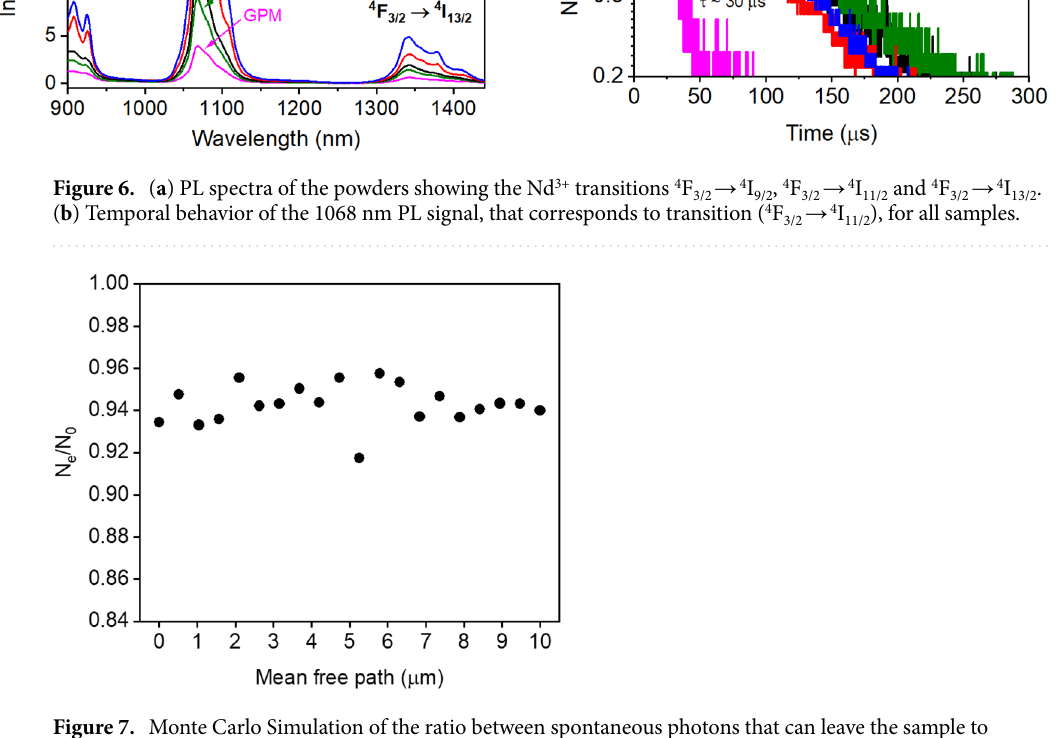
Figure 7. Monte Carlo Simulation of the ratio between spontaneous photons that can leave the sample to spontaneous photons that are generated within the host material as a function of the